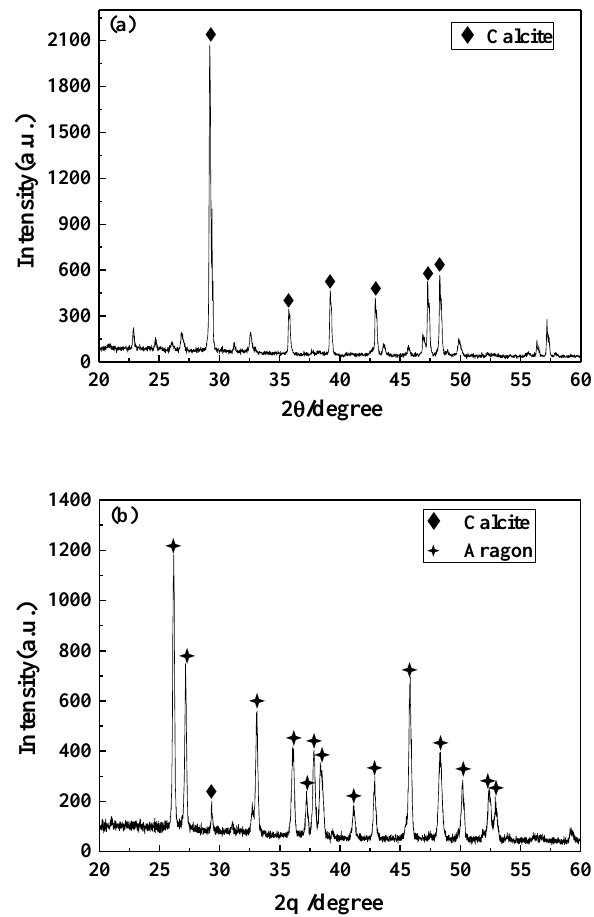
Figure 9. The X-ray diffraction (XRD) pattern of the calcium carbonate crystals formed in the blank ( a ) and the scale-forming solution containing 100 mg/L carbon nanoparticles ( b ).